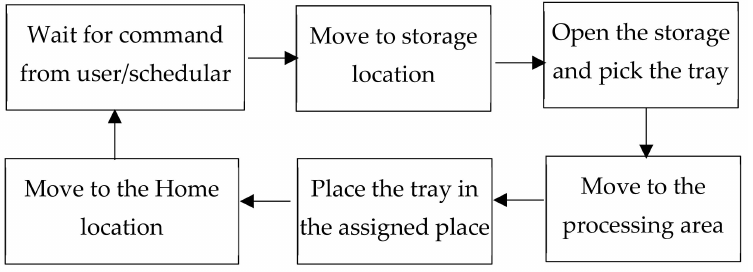
Figure 3. Task flow diagram for the experiment using centrifugal